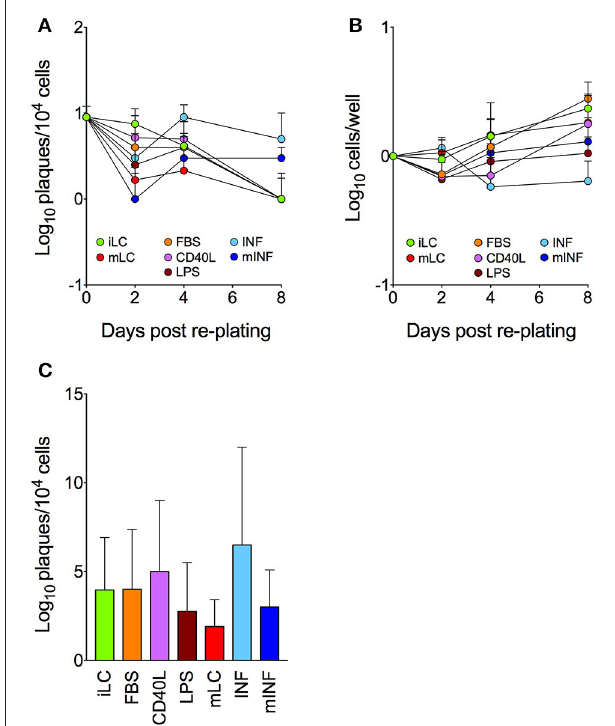
FIGURE 4 | Efficiency of viral reactivation in latently infected LC populations. CD34 + cells were exposed to TB40/E virions at a calculated MOI of 10 for 4 h, washed and cultured in iLC differentiation medium for 8 days. A portion of latently infected iLC harvested at day 8 was then plated onto uninfected HFF, and the number of plaques that developed during a period of 8–10 days was counted (day 0). The remaining iLC were re-plated in either iLC conditions or in each activation medium. Cells were collected at day 2, 4, and 8, counted and co-cultured with uninfected HFF for 8–10 days. The number of plaques that developed in each condition and at each time post re-plating (A) , the total number of cells per well (B) and the overall median number of plaques (C) were calculated. Graphs show median and median absolute deviation values of data collected with latently infected LC derived from five different CD34 + cell donors in two independent